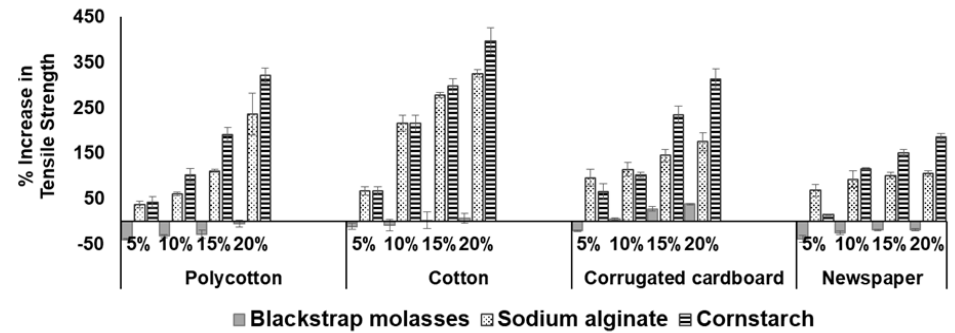
Figure 6. Percentage increase in tensile strength using different binders (error bars indicate standard error of the mean).